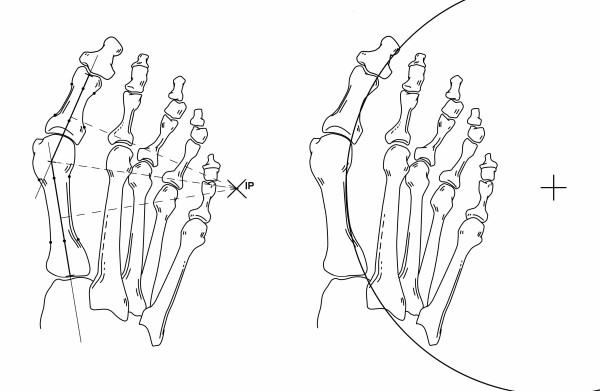
Position of the intersection point (IP) and of the center of the first metatarsophalangeal arc circumference (right) out of the foot but within a distance of a foot width in a case of moderate hallux valgus deformity.